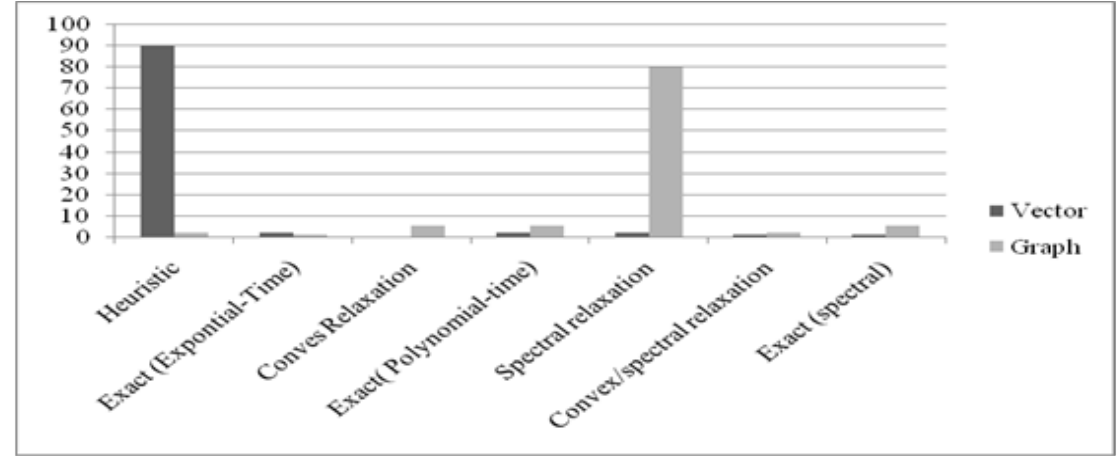
Figure 3. Chart representing approaches and presentation of data.